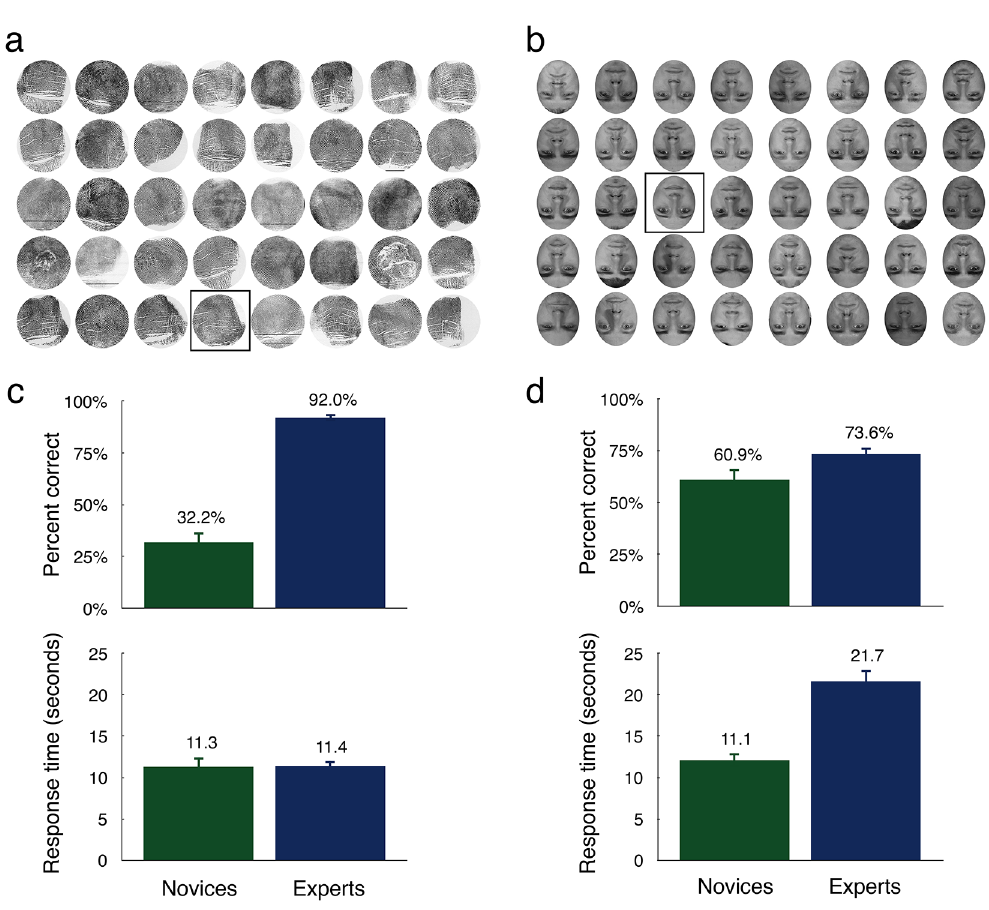
Fig 1. An examplefingerprintarray with a loop target (a), and an inverted face array with a female target (b). The mean percent correct and mean responsetime for novices (green) and experts (blue) on the fingerprint(c) and face (d) search tasks are depictedbeneatheach examplearray. Error bars represent the standard error of the mean.